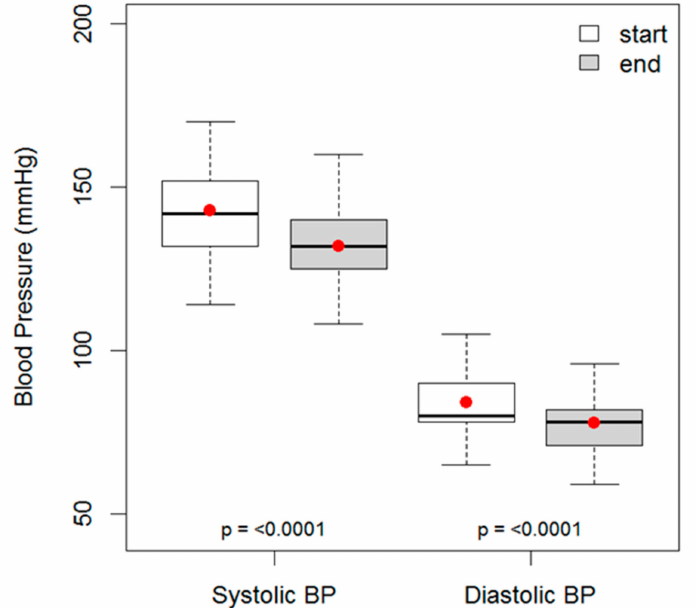
Figure 3. Box and whisker plots to show the distributions of the 154 patients’ systolic and diastolic blood pressure results before and after an average of 24 months on a low carb